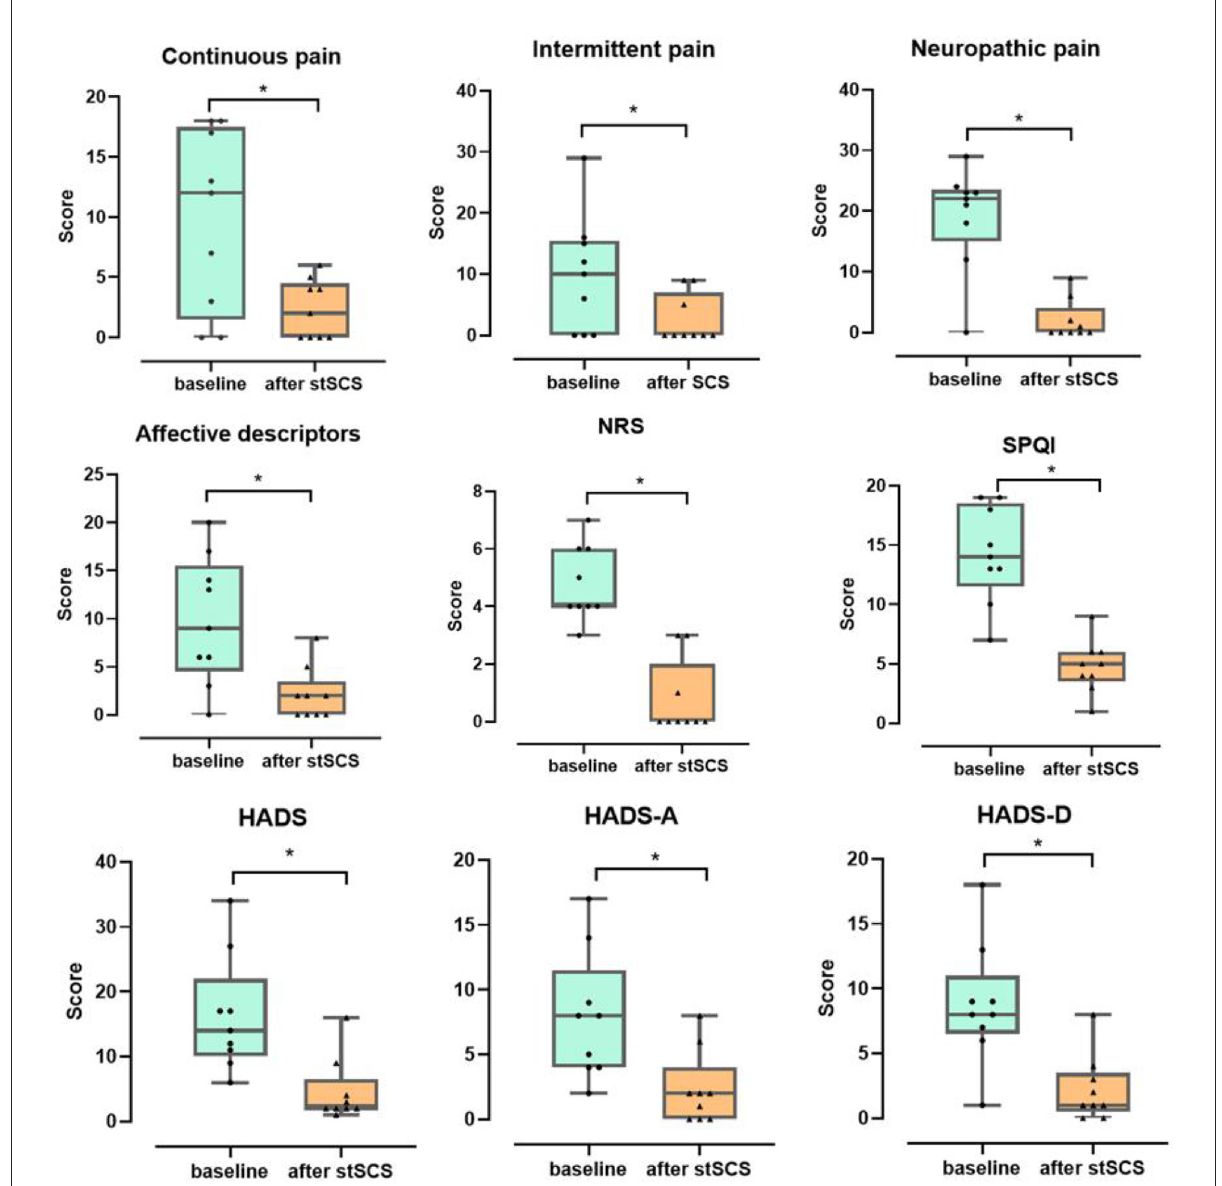
FIGURE2 Boxplots for the clinical outcomes for all patients at baseline (in green) and after stSCS (in orange). The beginning four boxplots represent the four subscale scores of the SF-MPQ-2 (continuous pain, intermittent pain, predominantly neuropathic pain, and affective descriptors). The last two boxplots represent the two subscale scores for the HADS (HADS-A and HADS-D). NRS, numeric rating scale; PSQI, Pittsburgh sleep quality index; SCS, spinal cord stimulation. * p < 0.05.